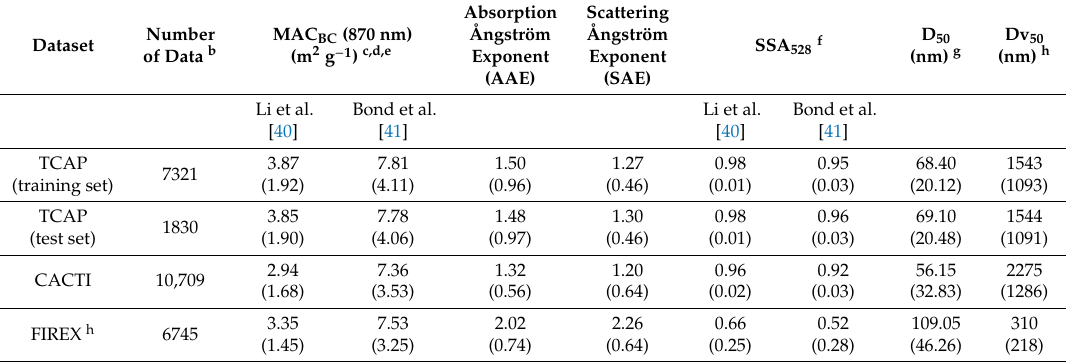
Table 1. Overview of the studies and aerosol properties. Aerosol properties are expressed as mean (standard deviation) a